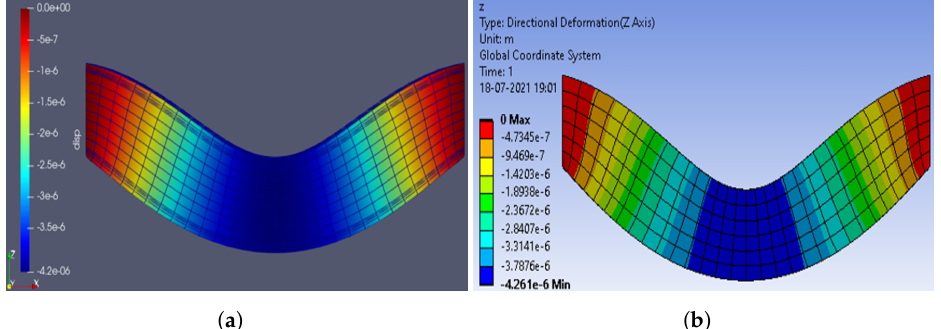
Figure 4. Both sides fixed beam submitted to self weigth. ( a ) Paraview (Python), ( b ) ANSYS. (Note: e − n indicates 10 − n )